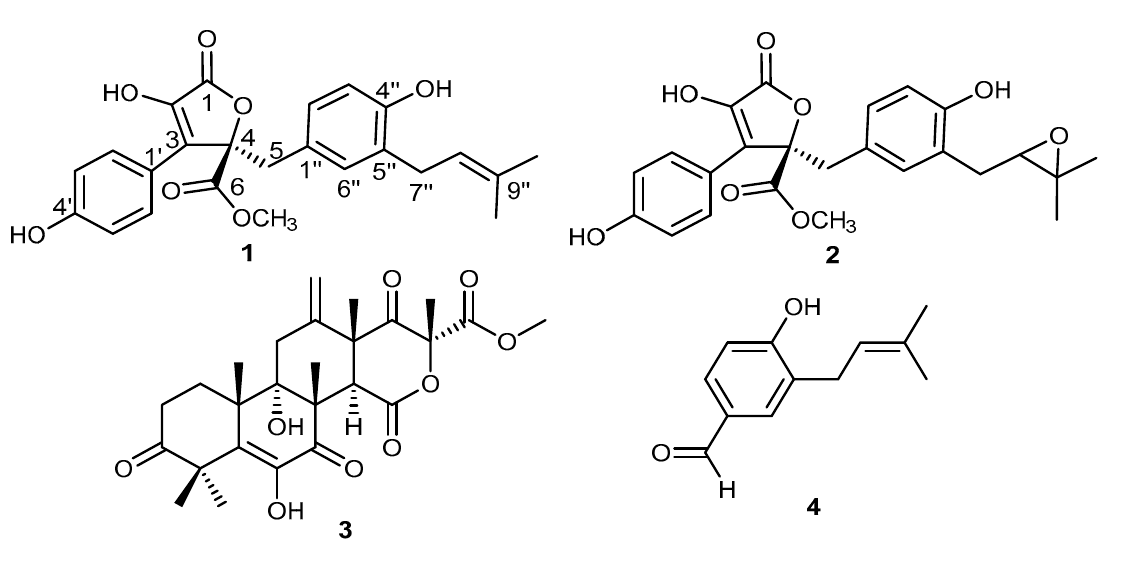
Figure 1. Chemical structures of 1 – 4 .